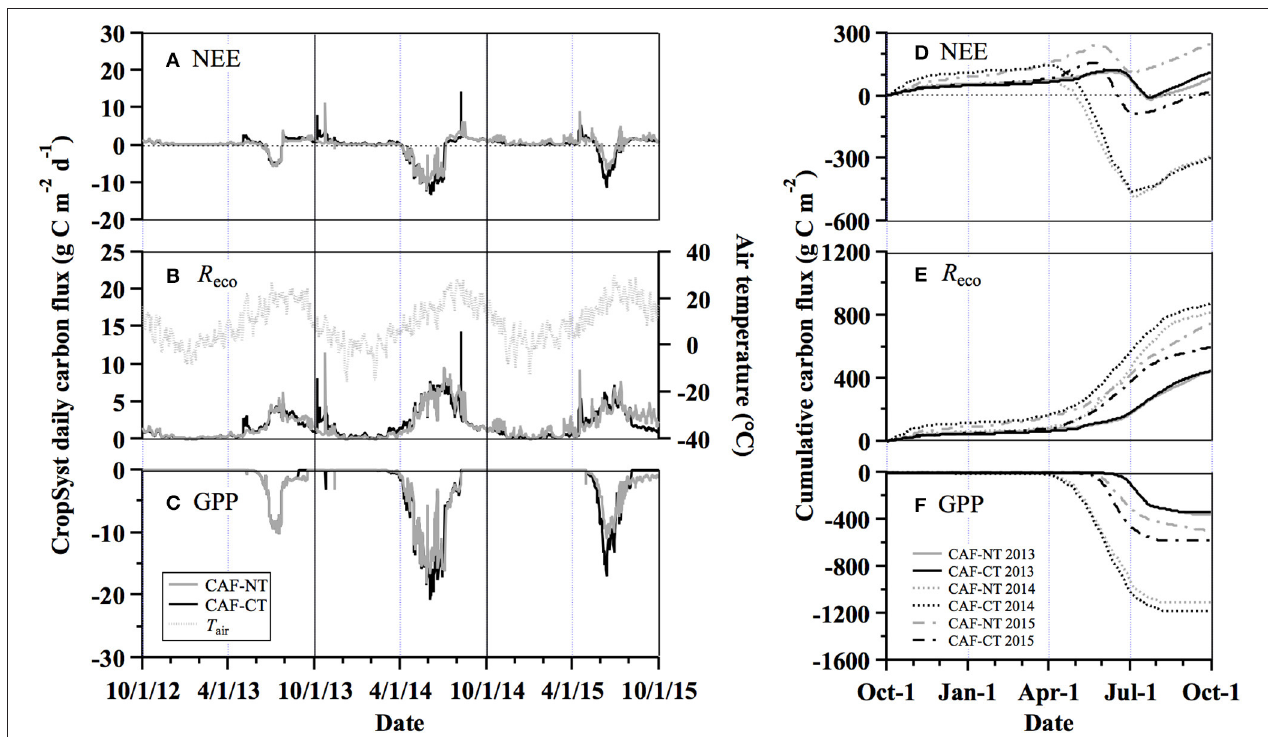
FIGURE 5 | CropSyst daily (A–C) and cumulative (D–F) net ecosystem exchange CO 2 (NEE), total ecosystem respiration ( R eco ), and gross primary productivity (GPP) at the no-till (CAF-NT) and the conventional tillage (CAF-CT) sites from October 1, 2012 to September 30, 2015. Daily mean air temperature ( T air ) was only plotted for CAF-NT to represent the general temperature conditions at